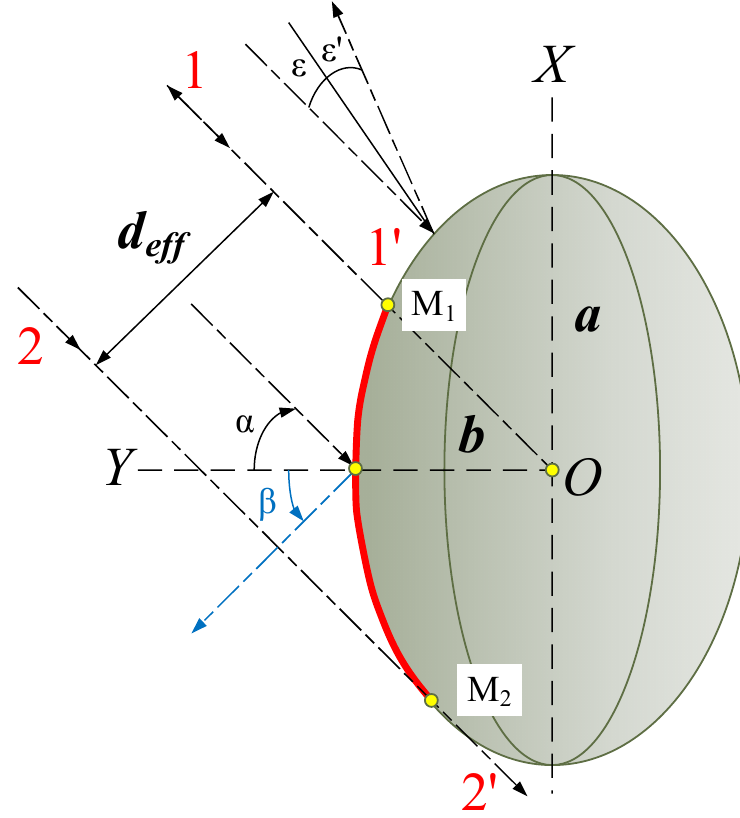
Figure 5. Determination of critical detection points M 1 and M 2 for the case of semi axis orientation (cid:1853) = (cid:3039) (cid:3294) , (cid:1854) = (cid:3029) (cid:3294) of the seed.